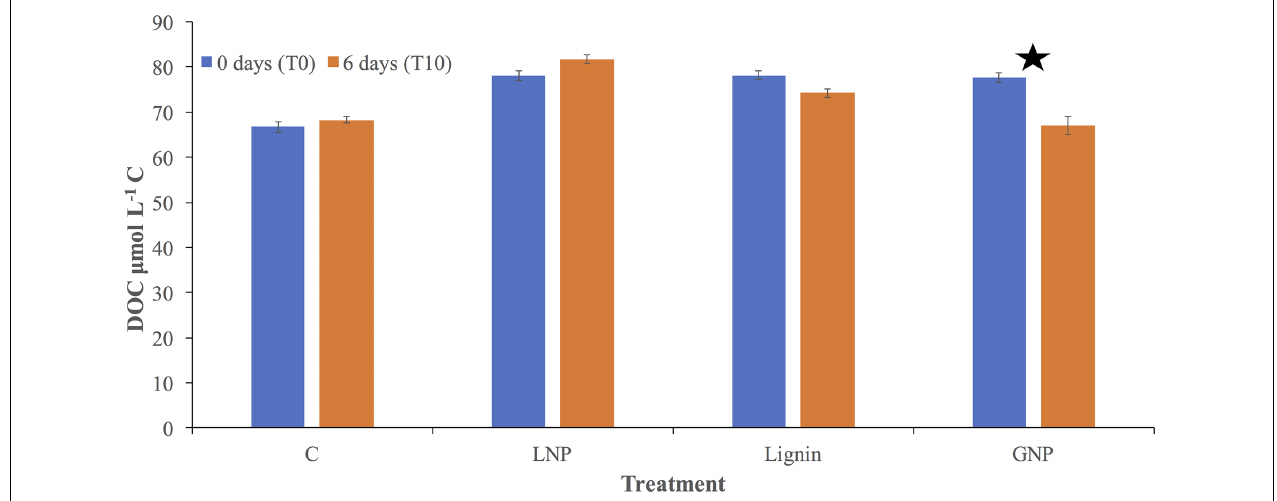
FIGURE 4 | Dissolved organic carbon (DOC; µ mol L – 1 C) concentrations for all treatments and controls. DOC was measured at the initial time point (blue) and after 6 days (orange). Error is shown as standard deviation between replicate samples and treatments. The star indicates a significant change (two sample t -test assuming unequal variances) in DOC between the two time